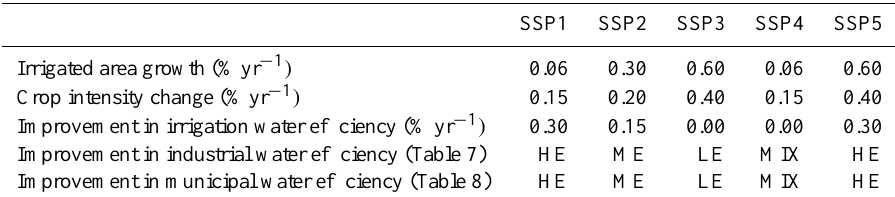
Table 9. Parameters for Eqs. (1)–(5).